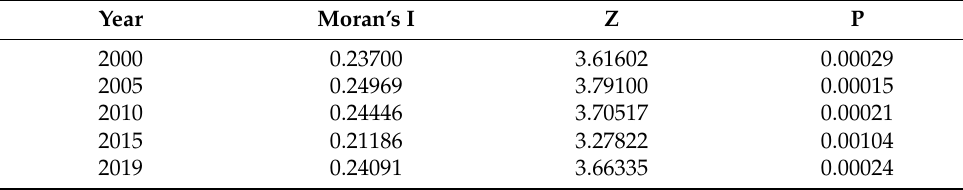
Table 5. Global Moran’s I index of the 3E coordination degree in